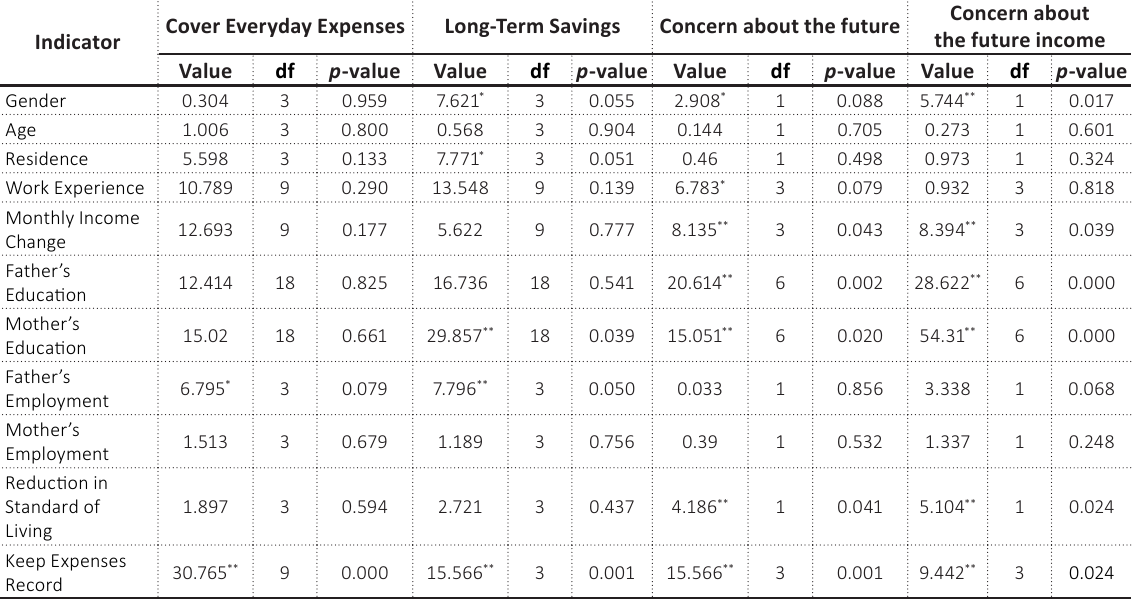
Table 2. Chi-square tests for financial well-being indicators against demographic and financial indicators